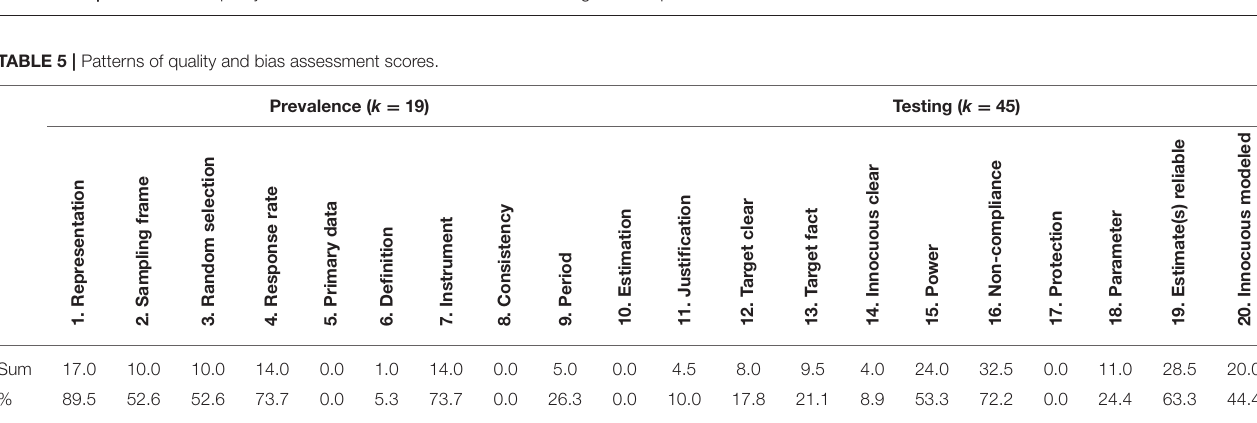
FIGURE 4 | Distribution of quality and bias assessment scores for CM testing and CM prevalence studies.